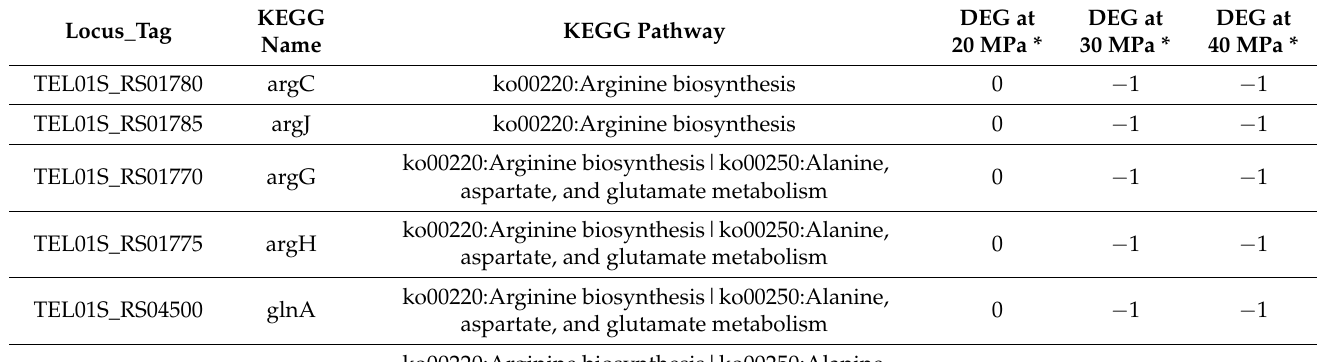
Figure 3. Significantly DEG-enriched KEGG pathways in the surface strain P. elfii subsp. lettingae cultured at 20 MPa compared to 0.1 MPa (one-tail z-test, p -value < 0.05). The Y -axis corresponds to the percentage of a specific KEGG pathway of all DEG-related KEGG pathways. Table 1. List of the DEG involved in amino acid metabolism/transport in the deep strain P. elfii